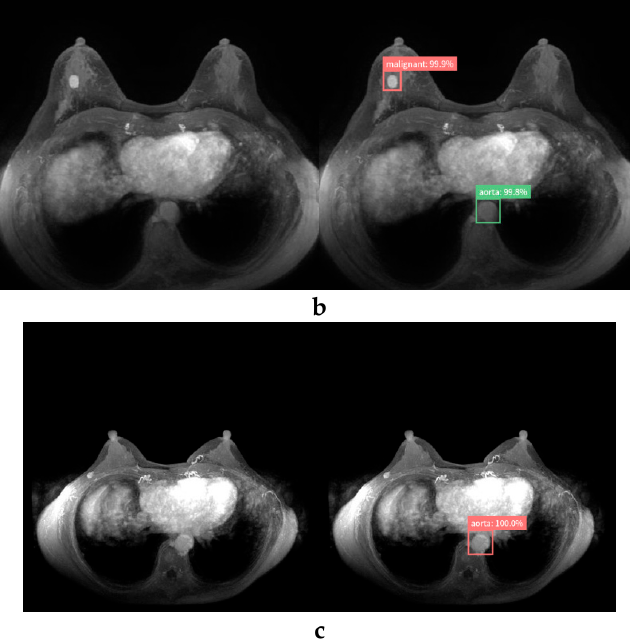
Figure 6. False-positive case ( a , b ) and false-negative case ( c ) diagnosed by the AI system (left, original image; right, image diagnosed by the AI system). The AI system mistakenly detected normal breasts ( a ) and fibroadenoma ( b ) and diagnosed them as malignant. The AI system failed to detect invasive ductal carcinoma near the right axilla. This may have been mistaken for an axillary lymph node ( c ). In the case of seven false-positives, five lesions were masses (mean size = 15.6 mm; range, 9–27 mm), three were diagnosed as fibroadenoma or intraductal papilloma (IDP), and the remaining two